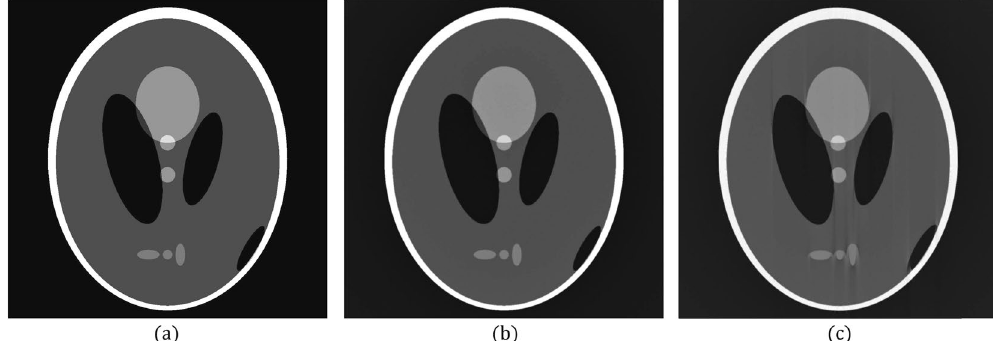
Figure 1. Tomographic images of a phantom reconstructed from 600 projections with 1024 parallel beams; the interval of the projection angles was 0.303°. ( a ) Original image. ( b ) Result obtained using correct reconstruction parameters. ( c ) Result obtained using an interval of 0.3° instead of